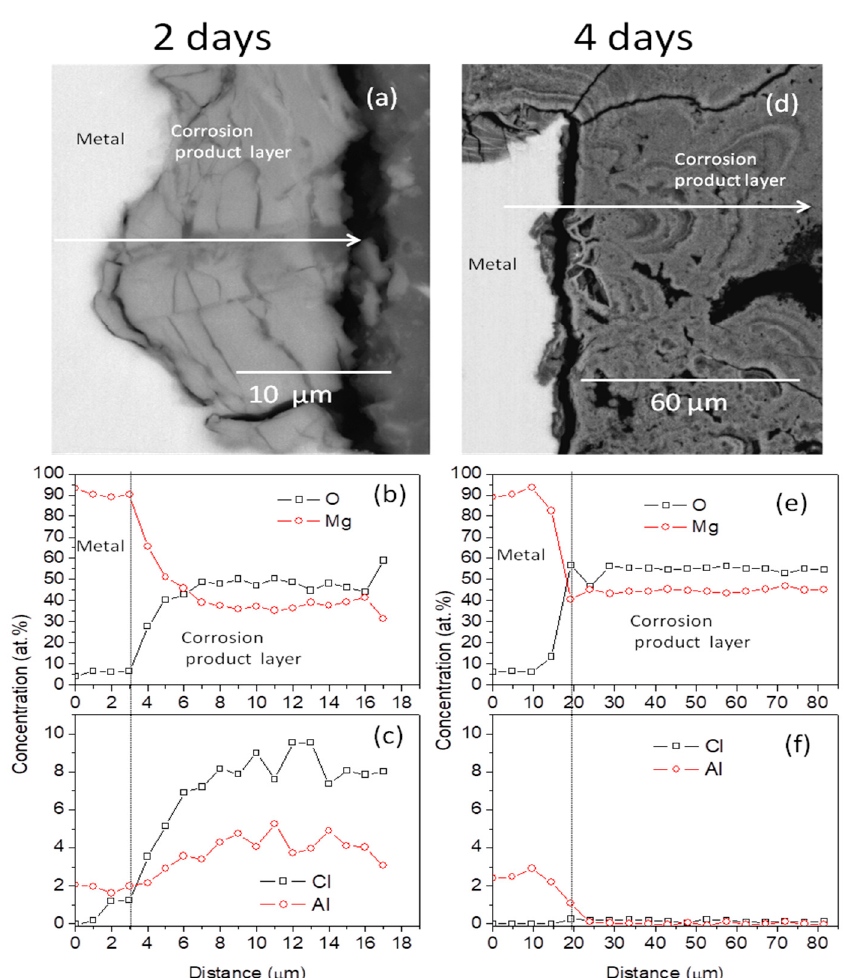
Figure 2. ( a , d ) BSE images and ( b , c , e , f ) EDS quantitative analysis of the cross-section of the uniform corrosion layer formed on AZ3B1 surface after immersion in Ringer’s solution (37 ◦ C) for ( a – c ) 2 days and ( d – f ) 4 days. Table 2. Atomic composition (EDS) of the cross-section of uniform corrosion layer formed on AZ31B surface after immersion in Ringer’s solution (37 ◦ C) for 2 and 4 days. Average values from 20 spectra. Exposure Time (days) O